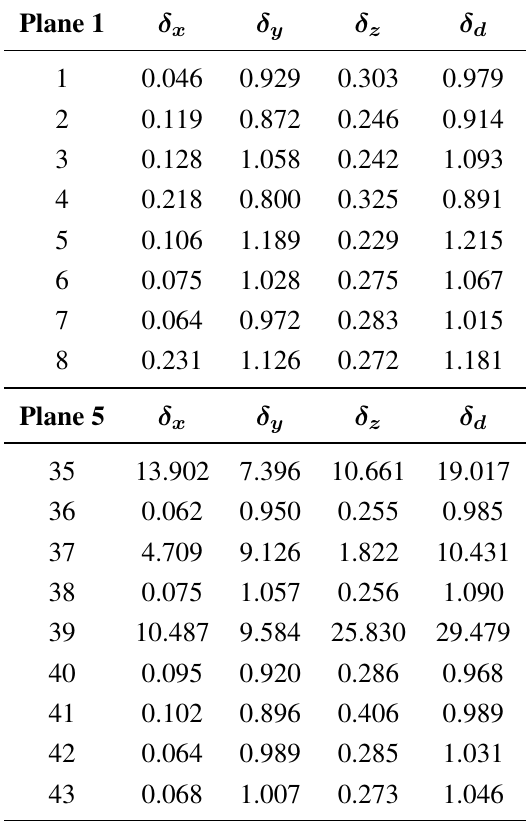
Table 1. The standard deviations of the repeated measurement of points (units: